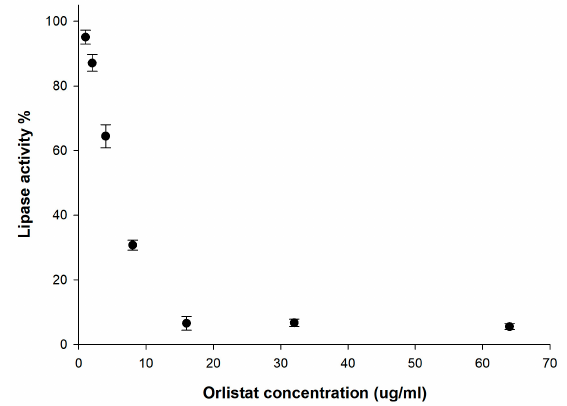
Figure 5. Influence of orlistat concentration on lipase activity.